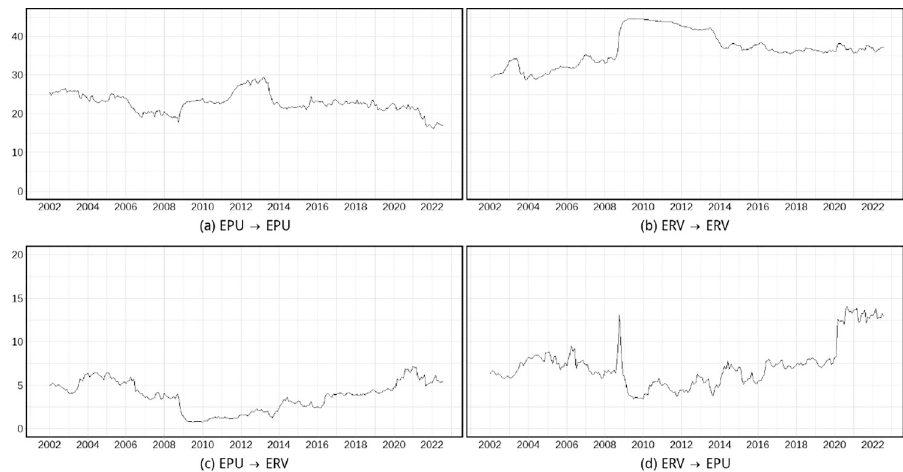
Fig 2. Time-varying characteristics of intra/inter-sector spillovers of global EPU and ERV. (i) This figure plots the intra/inter-sector spillovers of global EPU and ERV for a 60-month rolling window. (ii) Since we use a rolling window of 60 months and our sample starts in 1997, the starting year of this figure is